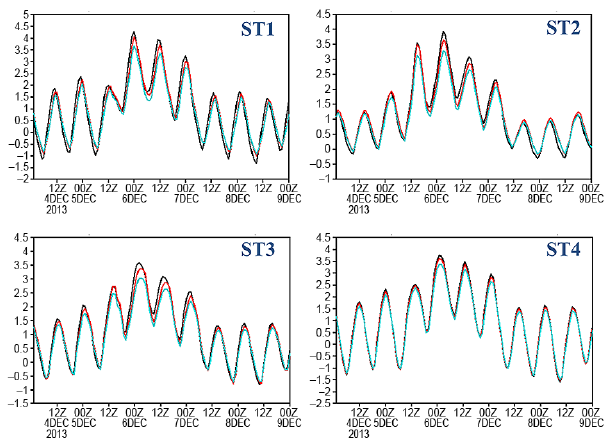
Figure 5. Time series of sea level elevation (SLE) in (m) at four coastal stations of the German Bight (ST1–ST4, see Fig. 1 for the locations). Black line corresponds to tide gauge observations, red line corresponds to the coupled wave–circulation model (WAM– GETM) and green line corresponds to circulation-only model (GETM).